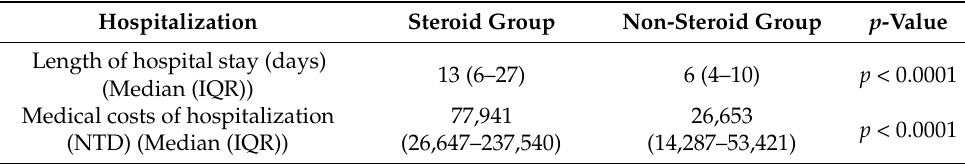
Table 4. Duration and cost of